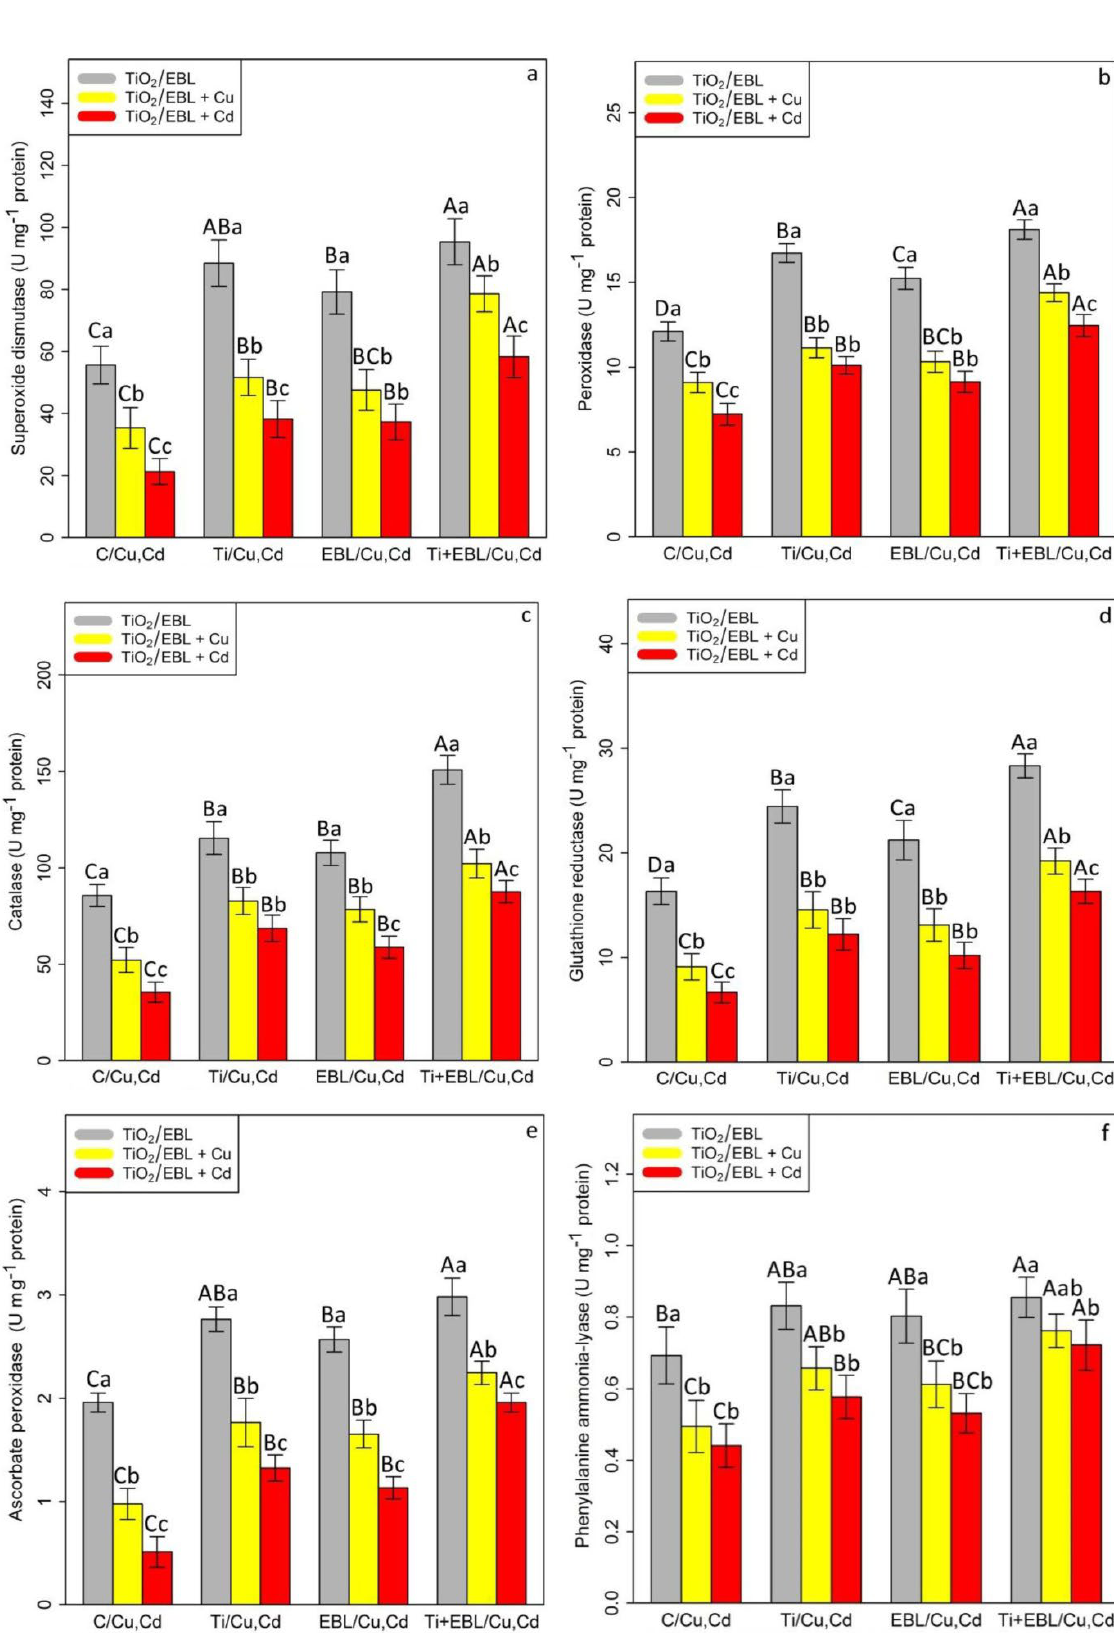
Figure 1. The impact of the co-application of 24-epibrassinolide and titanium oxide nanoparticles individually and combined on antioxidant enzyme activities (superoxide dismutase (SOD) ( a ), peroxidase (POX) ( b ), catalase (CAT) ( c ), glutathione reductase (GR) ( d ), ascorbate peroxidase (APX) ( e ), and phenylalanine ammonia-lyase (PAL) ( f )) in bamboo species ( Pleioblastus pygmaeus ) with 100